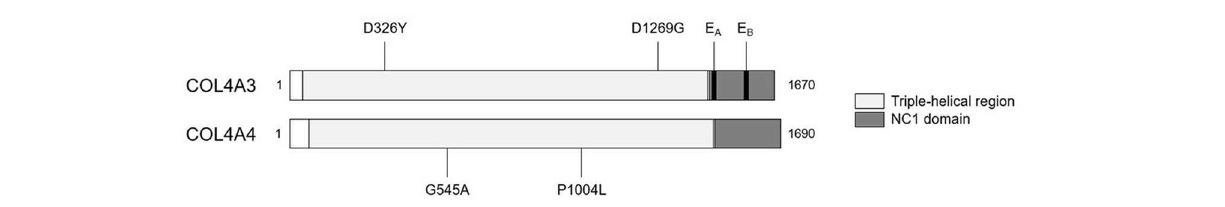
FIGURE 3 | Patient-restricted coding variants within type IV collagen proteins. Domain architecture and relative locations of missense variants within COL4A3 ( Uniprot: Q01955) and COL4A4 ( Uniprot: P53420) proteins that differed between the patient and the cord-blood donor. No patient-restricted variants were observed in COL4A5. The black bars represent anti-GBM disease-associated E A - α 3 and E B - α 3 epitopes.